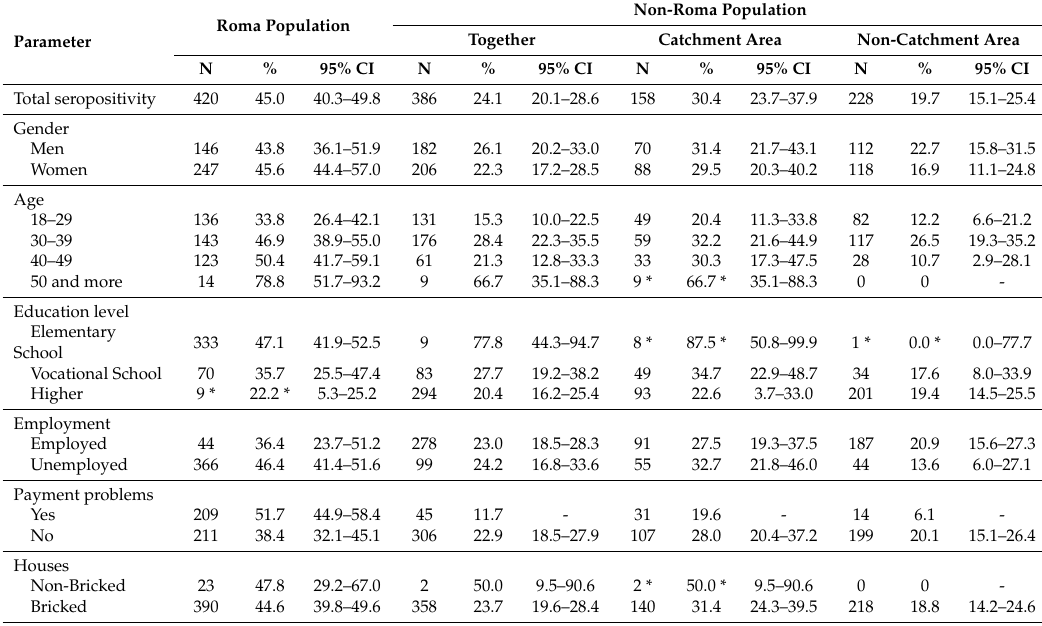
Table 2. Seropositivity to Toxoplasma gondii in relation to gender, age, education and